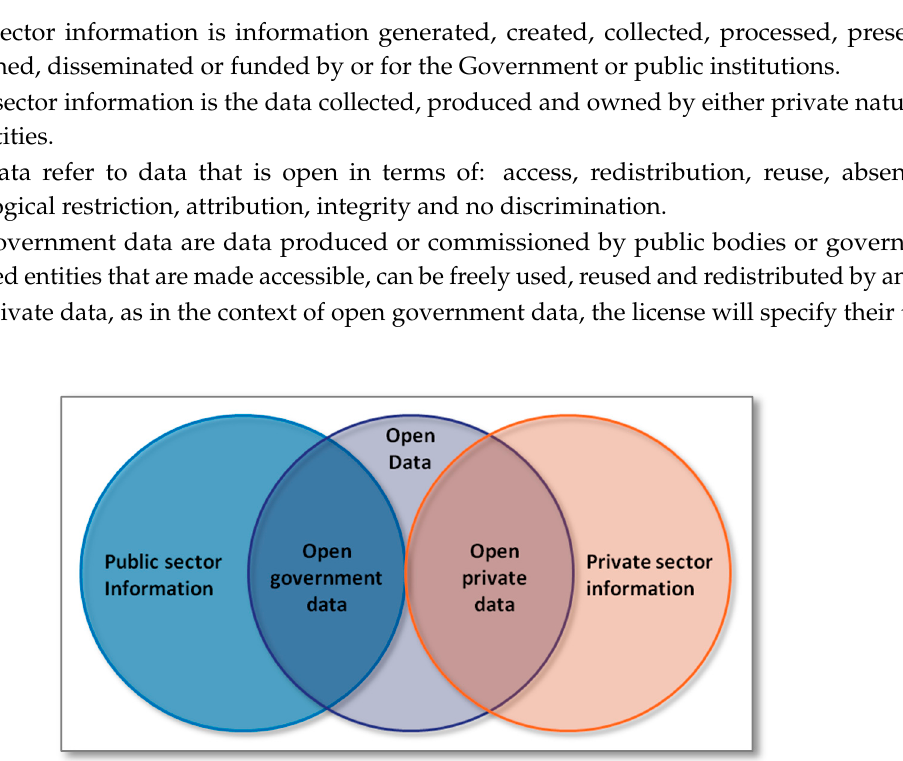
Figure 4. Open data value chain. Reproduced from reference [13], with permission from the European Union, 2015.